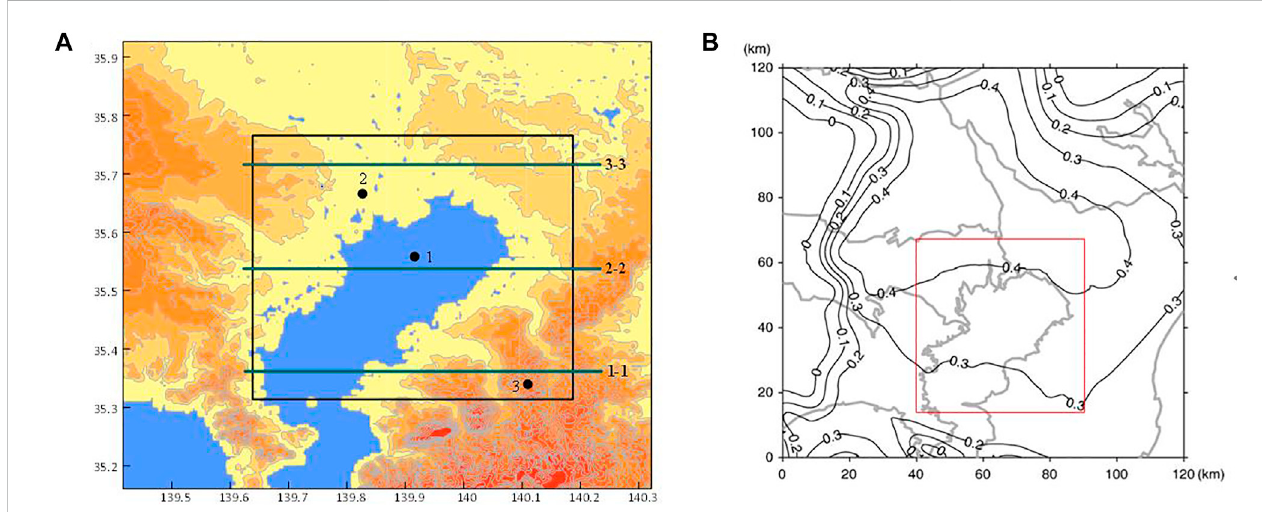
FIGURE 7 (A) Topography of the area around Tokyo Bay; (B) The fi rst interface depth determined by Koketsu et al. (2009).